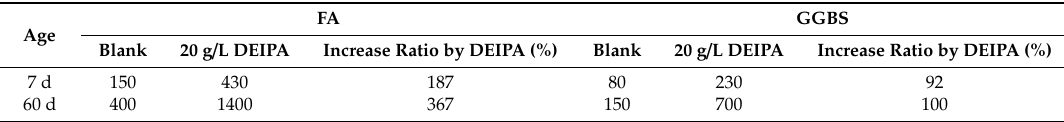
Table 7. Dissolution of Al in FA and GGBS suspension with and without DEIPA (mg / L). FA GGBS Age Blank 20 g / L DEIPA Increase Ratio by DEIPA (%) Blank 20 g / L DEIPA Increase Ratio by DEIPA